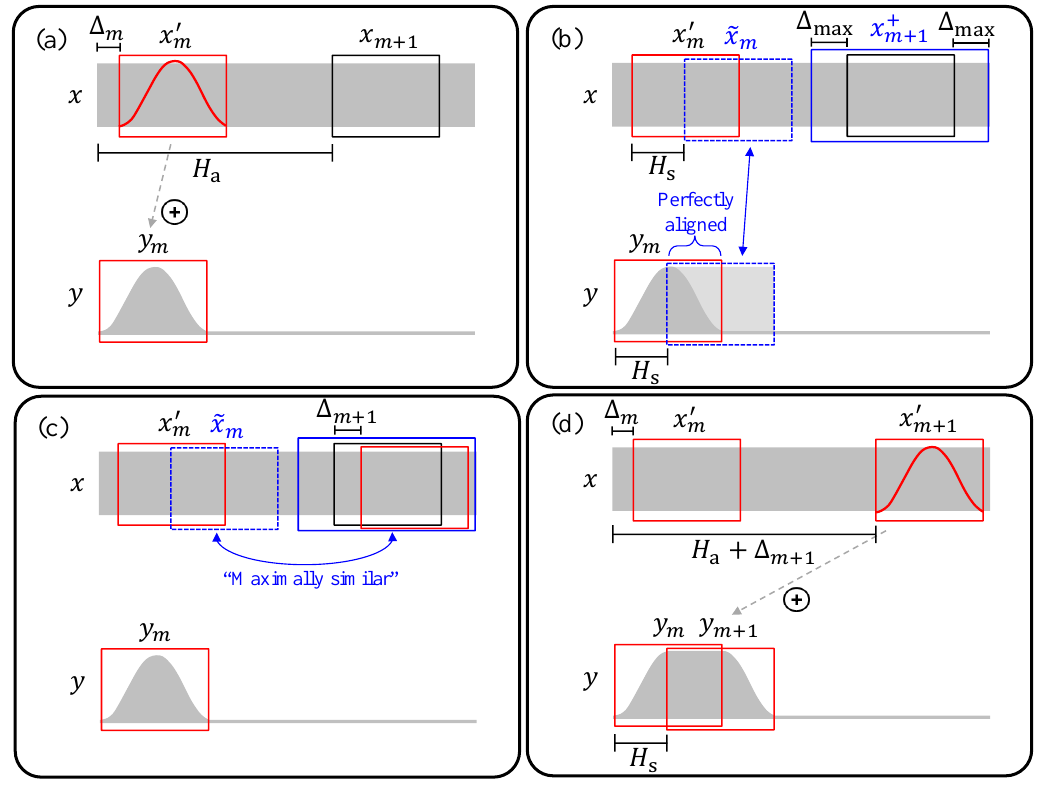
Figure 5. The principle of Waveform Similarity Overlap-Add (WSOLA). ( a ) Input audio signal x with the adjusted analysis frame x (cid:48) m . The frame was already windowed and copied to the output signal y ; ( b,c ) Retrieval of a frame from the extended frame region x + (solid blue box) that is as similar as m + 1 possible to the natural progression ˜ x m (dashed blue box) of the adjusted analysis frame x (cid:48) m ; ( d ) The adjusted analysis frame x (cid:48) is windowed and copied to the output signal y m + 1